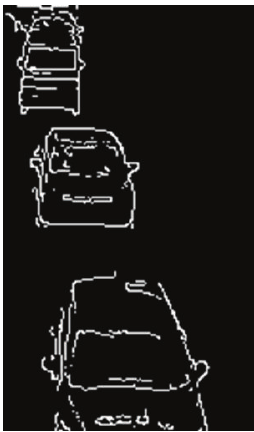
Figure 10: An example of four ROIs which are indicated in green